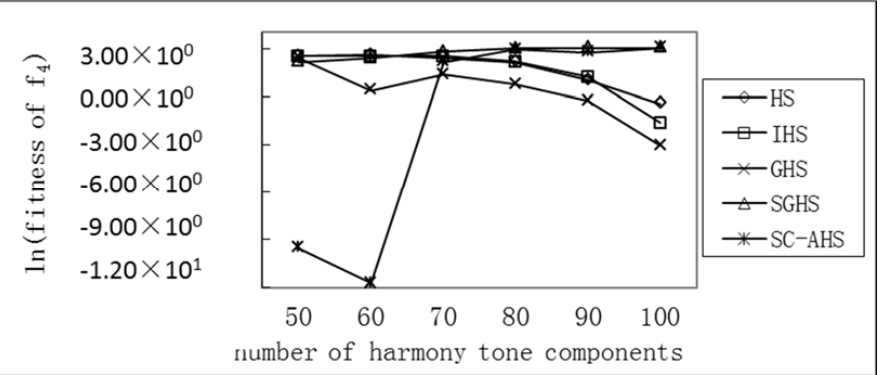
Figure 5. Comparison of the average optimum with different harmony tone components of the Ackley function.